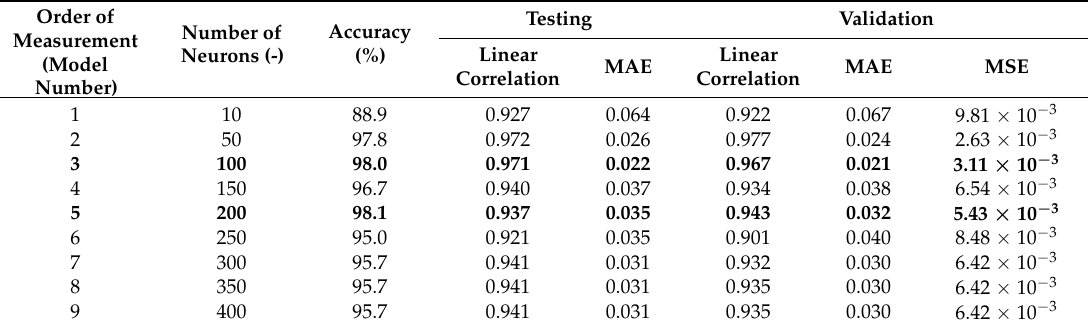
Table 5. The trained models—Training period: 12 th of May 2018.